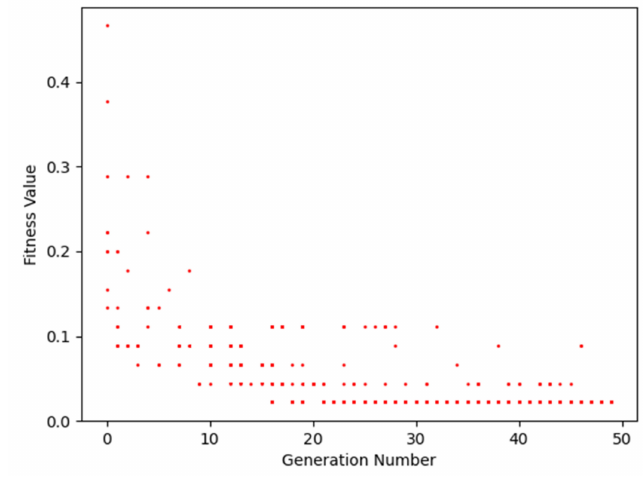
Figure 10. Feature subset searching process using GA.